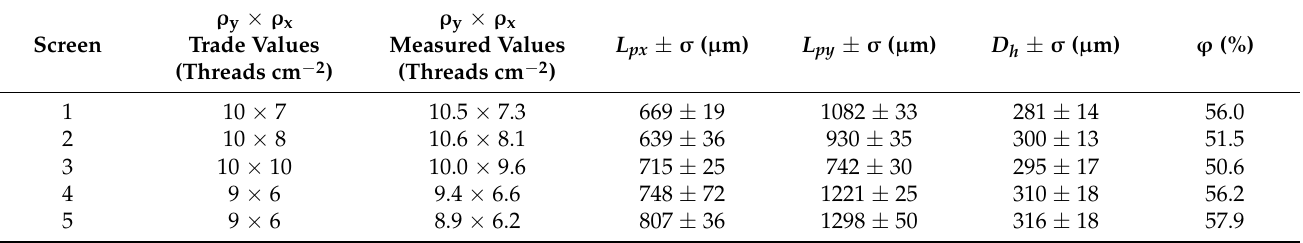
Table 2. Results of geometrical analyses: mean density of threads in warp ρ y and weft ρ x directions; mean hole width L px ; mean hole length L py ; mean thread thickness D h ; porosity ϕ .